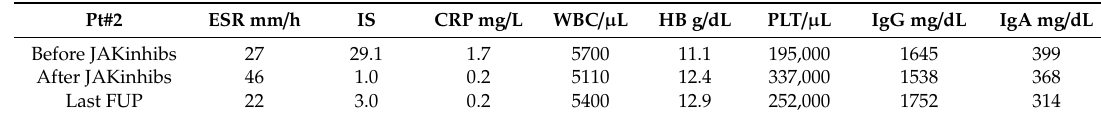
Table A2. Patient #2 laboratory findings.